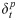
Correlation of average utility rate and size of TD error.(A) As the utility r of a reward increases, putatively from a change in motivational state, both the average utility rate ρ (assumed to be signalled by tonic dopamine) and the size of TD error δtp in response to a trial-start cue (phasic dopamine) increase. (B) A negative correlation between TD error and latency is observed. Here, we again assume the lever-pressing task depicted in Fig 3B. The critic is assumed to receive only indirect information about the actor’s choices. Model parameters: a = −0.05, b = 0, τ
post = 0.5 s, τ
I = 0 s, β = 1.